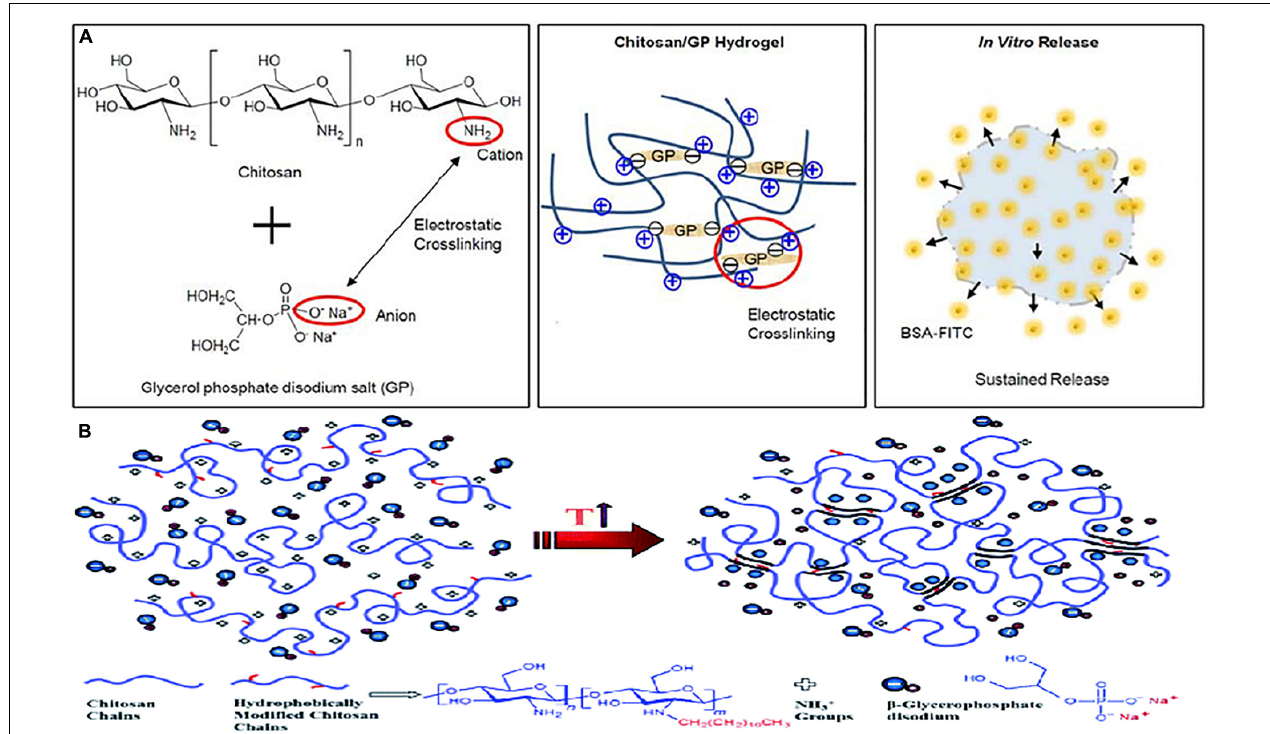
FIGURE 2 | (A) Schematic image of chitosan/GP hydrogel formation via electrostatic crosslinking between amine cationic groups of the chitosan chains and the phosphate anionic groups of the GP, and in vitro release of BSA-FITC from BSA-FITC-loaded chitosan/GP hydrogels (Kim G. O. et al., 2012). Licensed under Creative Commons: Kim J. K. et al. (2012). (B) Illustration of the molecular interactions involve in the thermo-gelation process of chitosan- β -glycerophosphate. Licensed under Creative Commons: Dashtimoghadam et al.